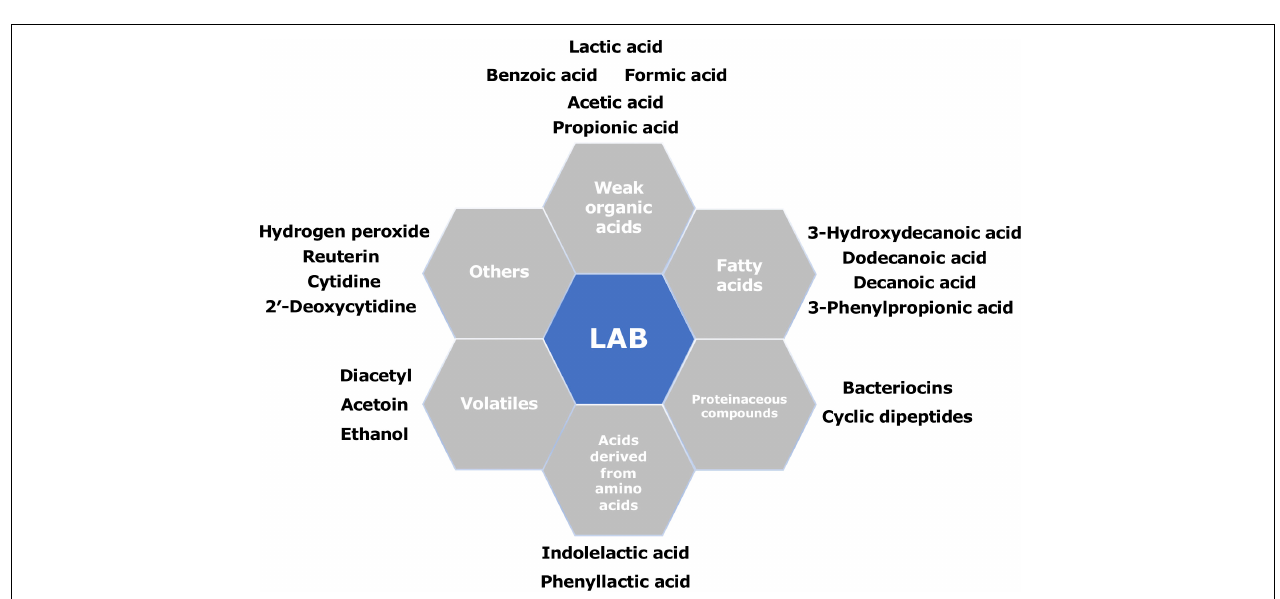
FIGURE 1 | Primary mechanisms of antimicrobial activity of bioprotective cultures. Left: Production of antifungal metabolites by lactic acid bacteria. Right: Competition for available nutrients by lactic acid bacteria.